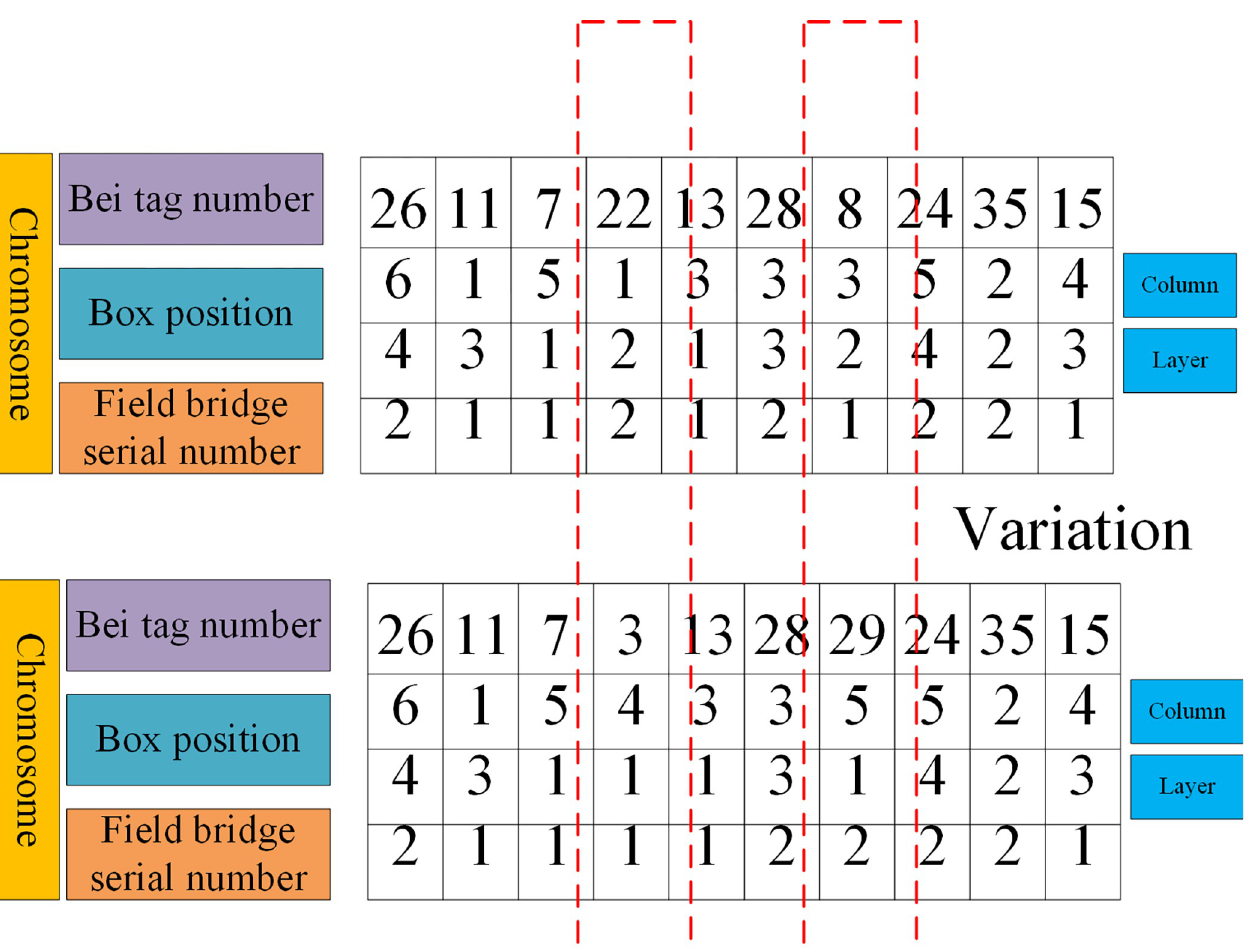
Fig 9. Variation operation diagram.